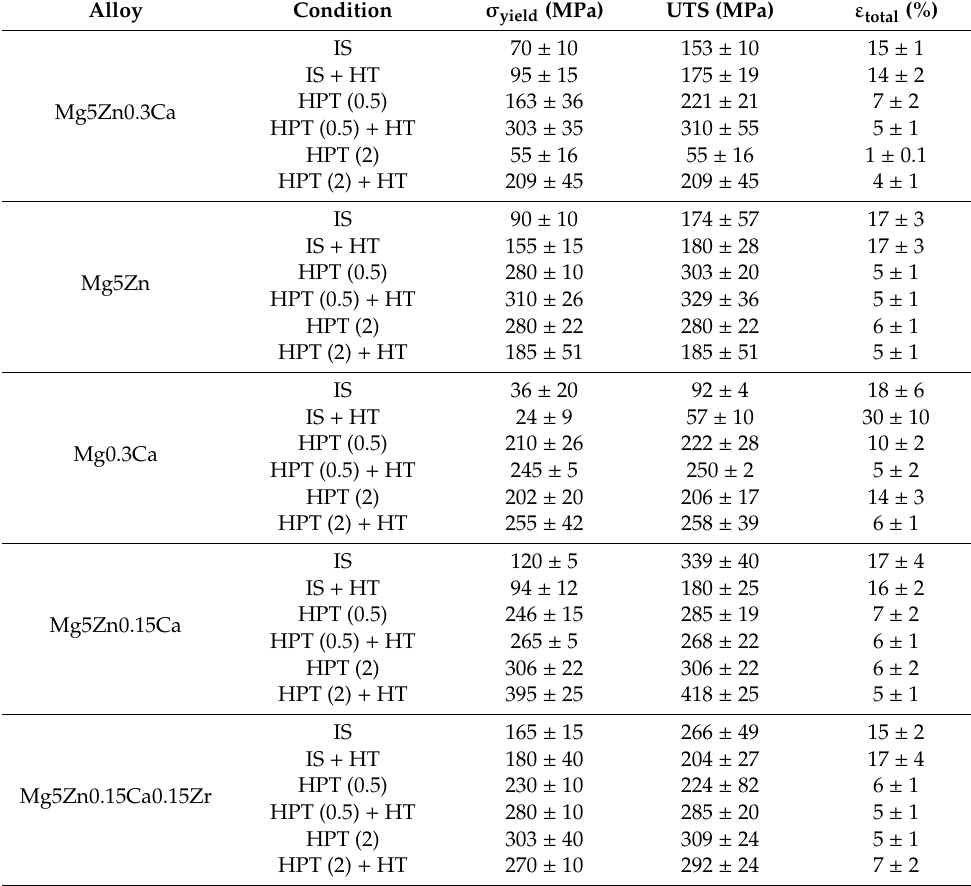
Figure 13. Representative tensile stress–strain curves of IS, IS and heat-treated, HPT-processed (0.5 and 2 rotations) and HPT-processed and subsequently heat-treated Mg5Zn samples. Both heat treatments were done at 100 ◦ C through 24 h. Table 4. Average values and standard deviations of yield strength σ yield , ultimate tensile strength (UTS) and total engineering strain ( ε total ) of all alloys in di ff erent conditions. HPT deformation was done